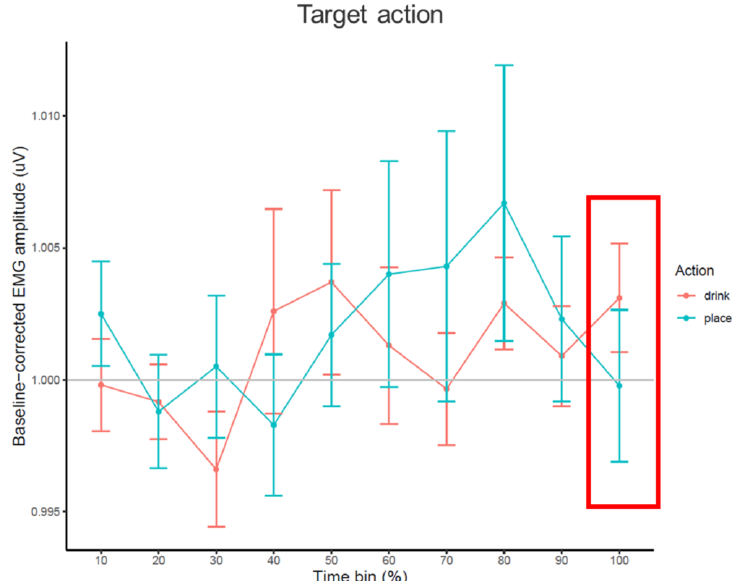
Figure 6. Line chart of average baseline-corrected EMG amplitude ( µ V) during each percentage (%) time bin of the action part of the video for both actions, drink and place with standard error bars ( ± 1 SEM ) and a grey line at baseline level (y = 1). Time bin used for statistical analysis in the red